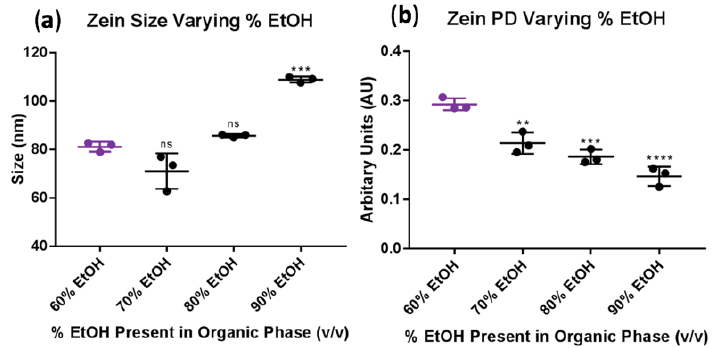
Figure 3. Impact of the percentage of ethanol present on Zein nanoparticles (NPs): ( a ) diameter; ( b ) polydispersity (PD).